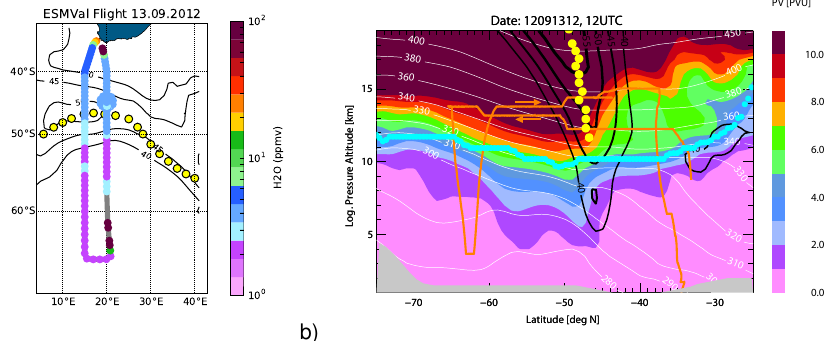
Figure 2. Flight pattern of the ESMVal flight on 13 September 2012. The black contours illustrate the horizontal westerly wind from ECMWF data. Yellow dots represent the vortex edge derived from the Nash criterion (Nash et al., 1996) based on ECMWF data. (a) Horizontal map of water vapor mixing ratios measured by FISH (5min averaged data) is color-coded on the flight path (gray indicates data gaps due to the dive). (b) Meridional cross section of PV along the flight path (orange line) calculated from ECMWF data. Cyan dots represent the ECMWF thermal